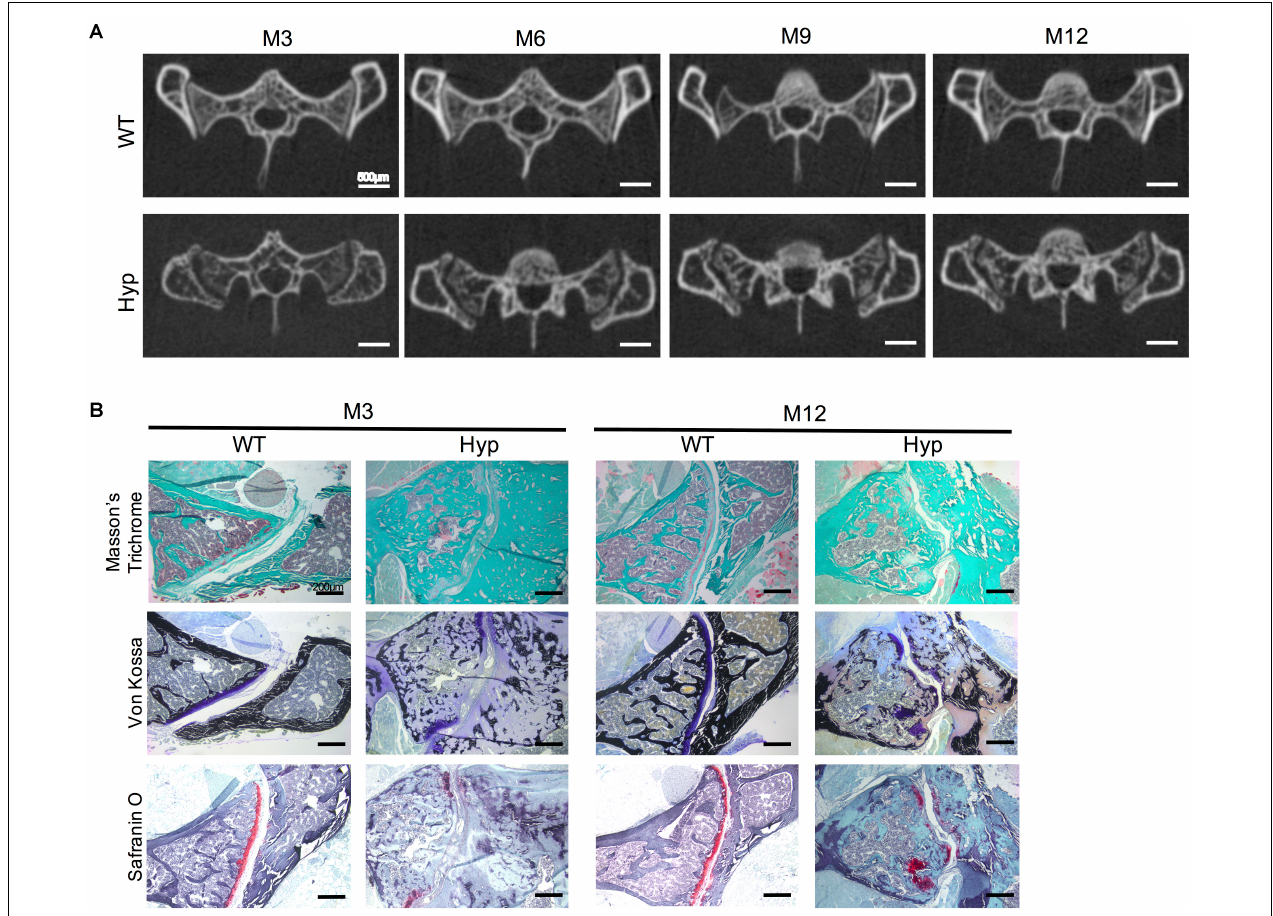
FIGURE 6 | Features of sacroiliac joint of Hyp and WT mice. (A) Micro-CT analysis showed bone erosion of the sacroiliac joint in Hyp mice which appears at early stages and progressed up to M12 (representative micro-CT sections from Hyp# 2 mouse) (scale bars, 500 µ m). (B) Masson’s trichrome staining displayed that sacroiliac bone of Hyp mice presented a large amount of collagen matrix compared to WT mice. Von Kossa staining showed a weak mineralization (in dark) of the Hyp collagen matrix revealing an enlarged osteoid characteristic of features of osteomalacia bone. Safranin O staining revealed high wear of cartilage at M3 in Hyp mice (scale bars, 200 µ